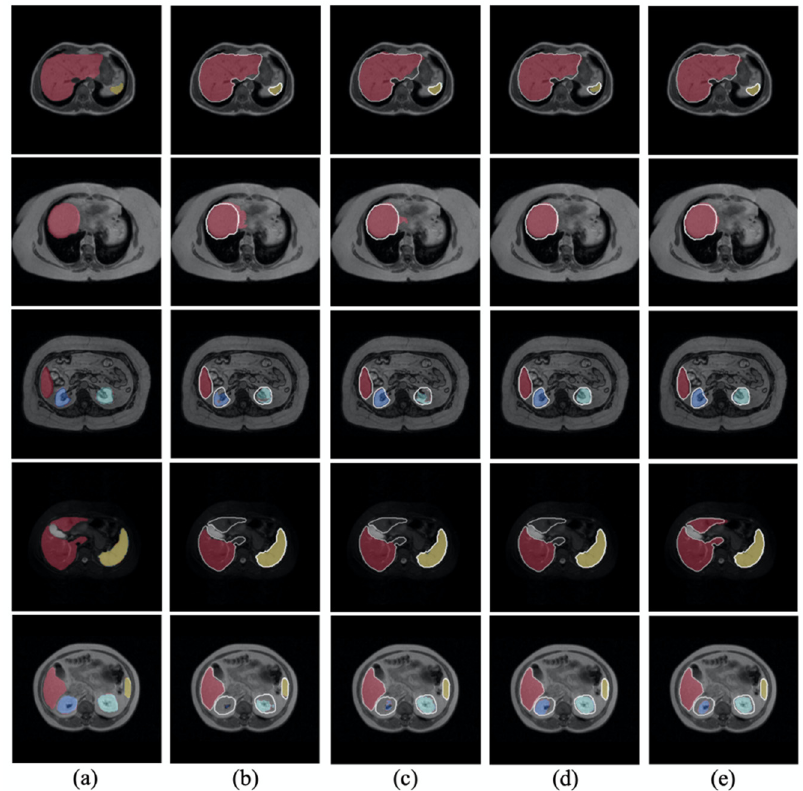
Figure 2. Qualitative comparison of segmentation results of our framework on the CHAOS dataset: ( a ) ground truth, ( b , c ) results of Segnet and nn-Unet, and ( d , e ) results of our method implemented on Segnet and nnUNet. The red region represents the liver, the blue region represents the right kidney, the cyan represents the left kidney, and the yellow represents the spleen. The white line denotes the boundary of the ground truth.